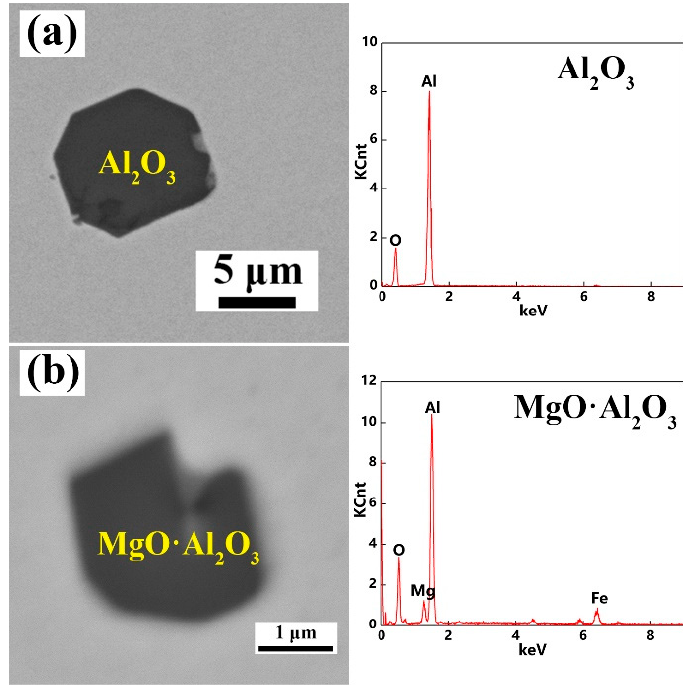
Figure 4. Main inclusions in the melts. ( a ) A-1 and ( b ) A-2.